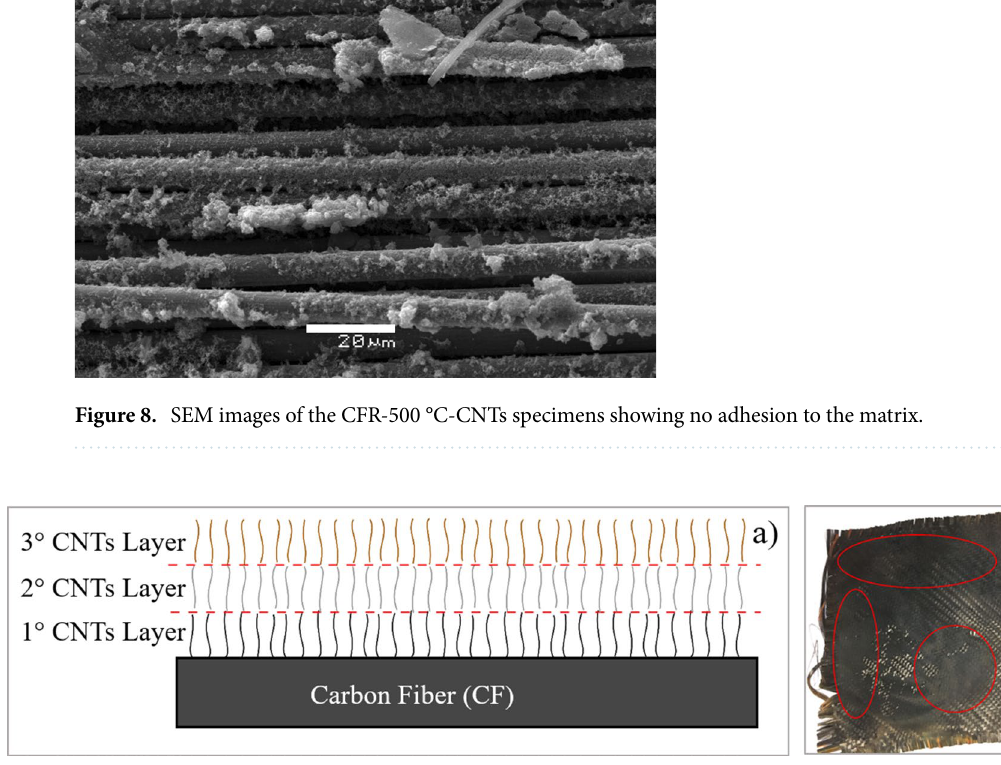
Figure 9. ( a ) Scheme of the possible mechanism for CNT growth by layer on VCFs and RCFs via Poptube. ( b ) CF composite with non-homogeneous growth of